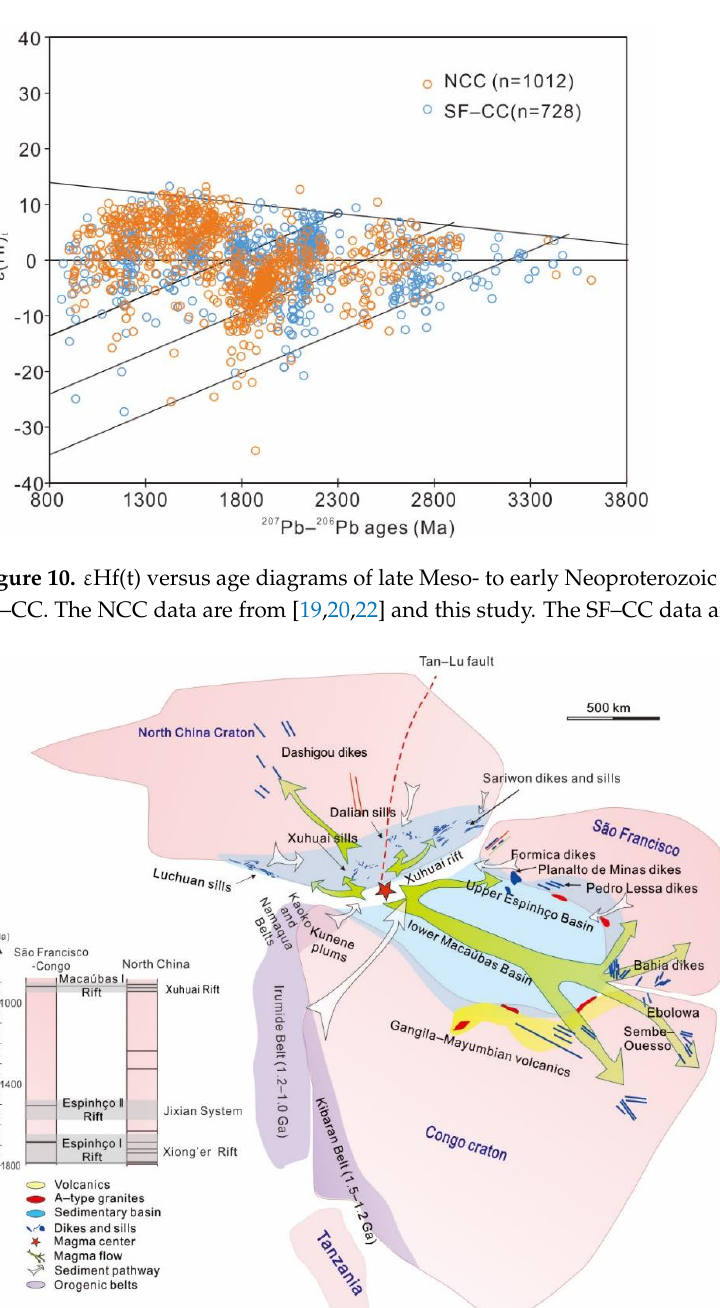
Figure 11. A speculation of paleogeographic reconstruction of the NCC in the early Neoproterozoic era [22]. The possible extend of NCC follows [77]. The possible extension of “broad” SF – CC follows [103].